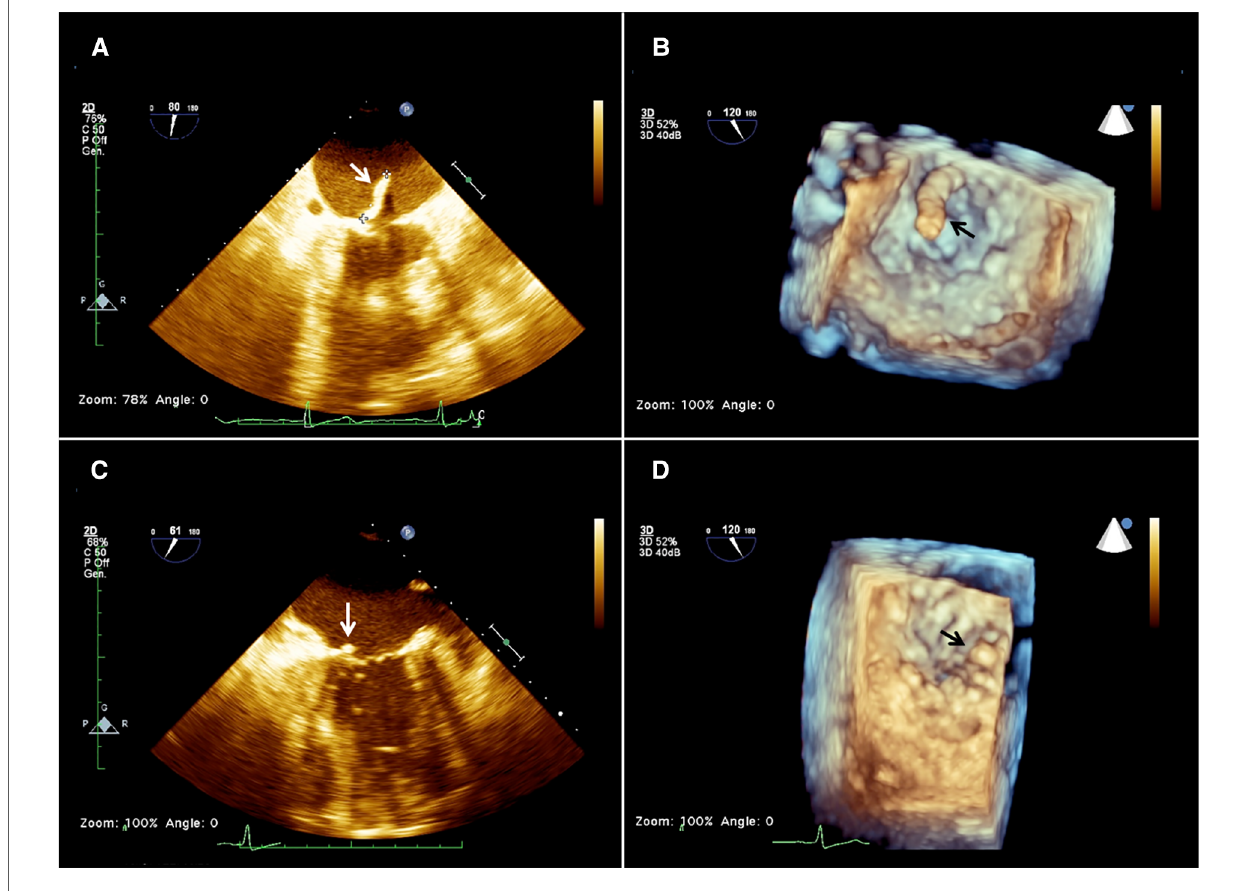
FIGURE 1 2d ( A ) and 3D ( B ) preoperative transesophageal echocardiography (TEE) showing the presence of a mass (arrow) attached to the base of the anterior mitral lea fl et on the atrial aspect of the mitral valve, and 2D ( C ) and 3D ( D ) postoperative TEE showing a residual minimal stump